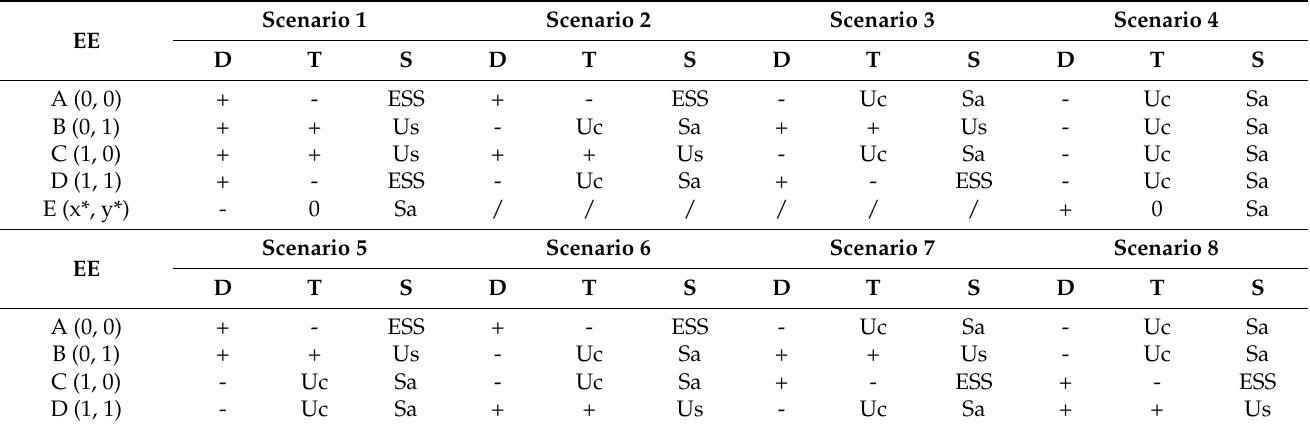
Table 4. Local stability of evolutionary equilibriums.